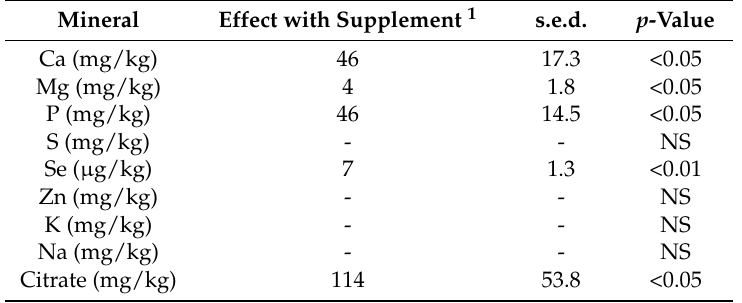
Table 6. Effect of dietary mineral supplementation on milk mineral and citrate concentrations. Mineral Effect with Supplement 1 s.e.d.